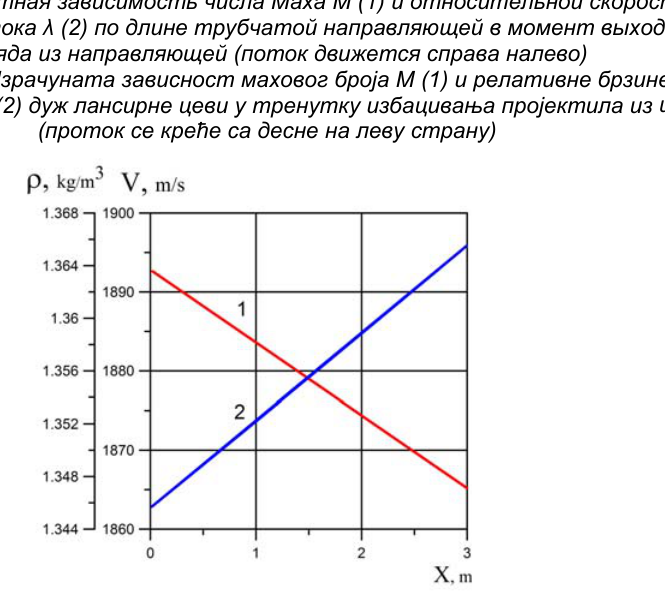
Figure 4 – Calculated dependence of the Mach number M (1) and the relative velocity of the gas stream λ (2) along the length of the tubular guide at the moment the projectile leaves the guide (the flow moves from right to left)